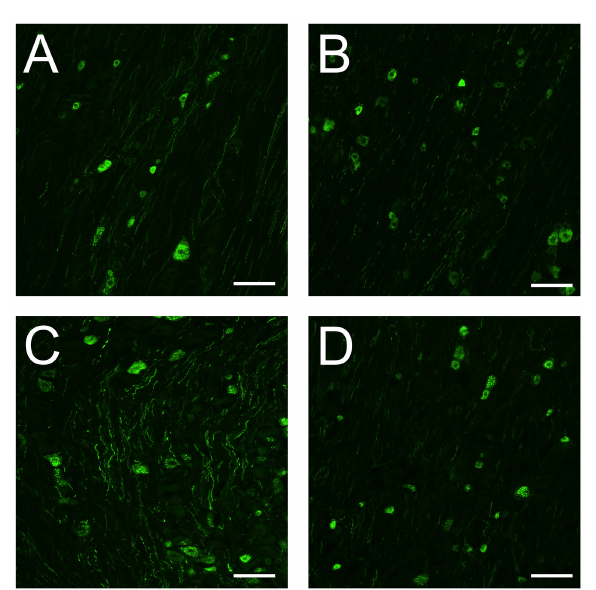
FIGURE6 Immunohistochemistry on CGRP in the TG. (A) In the TG of fresh rats, granular shaped patterns were detected in the cytoplasm of CGRP positive neurons, while CGRP positive fibers were button shaped. (B) In the TG of sham rats, similar patterns were detected in both neurons and fibers to that of fresh rats. The immunoreactivity of both neurons and fibers appears similar in intensity to that of fresh rats. (C) In the TG of CFA rats, similar patterns were detected in both neurons and fibers to that of fresh and sham rats. The immunoreactivity of CGRP positive neurons were like that of fresh and sham rats, while the immunoreactivity of the fibers appears more enhanced. (D) In the TG of CFA + anti-CGRP rats, similar patterns were observed as in previous groups. The immunoreactivity of both neurons and fibers appears similar in intensity to that of fresh and sham rats. Scale bar is 100 µ